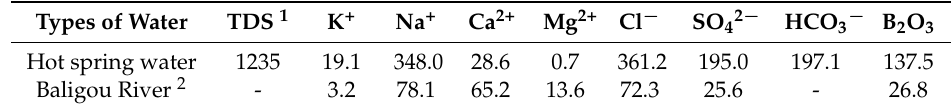
Table 1. Chemical composition of the hot spring water in mg/L [6] (Refer to Figure 1 for the location). Types of Water TDS 1 K + Na + Ca 2+ Mg 2+ Cl − SO 42 −